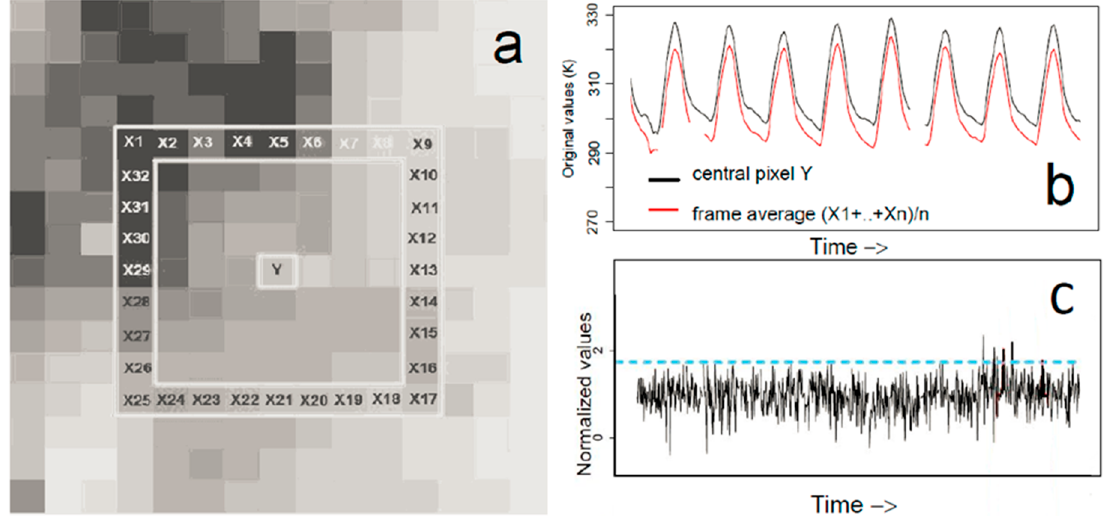
Figure 1. ( a ) An example of anomaly detection. ( b ) The value of every pixel of the image is divided by the average of an open frame of neighboring pixels. The pixels in between the central pixel and the frame are not included, and the averages are calculated based only on the number of available pixels. ( c ) The procedure is repeated for all images of the dataset, resulting in a normalized time series for every pixel (black solid line). Then a mean + 2sigma threshold (blue dashed line) is applied to each pixel’s normalized time series to distinguish extreme values that are then regarded as anomalies. Note: the size of the frame shown in this Figure is small for clarity, and it does not correspond to the frame we used in this study.